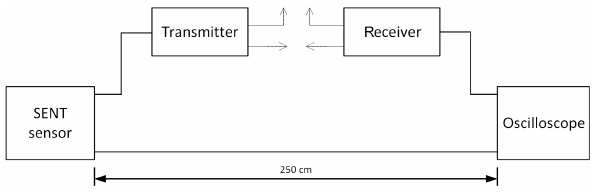
Figure 4. Schematic of the SENT setup; for PWM measurement just replace the SENT sensor with a PWM